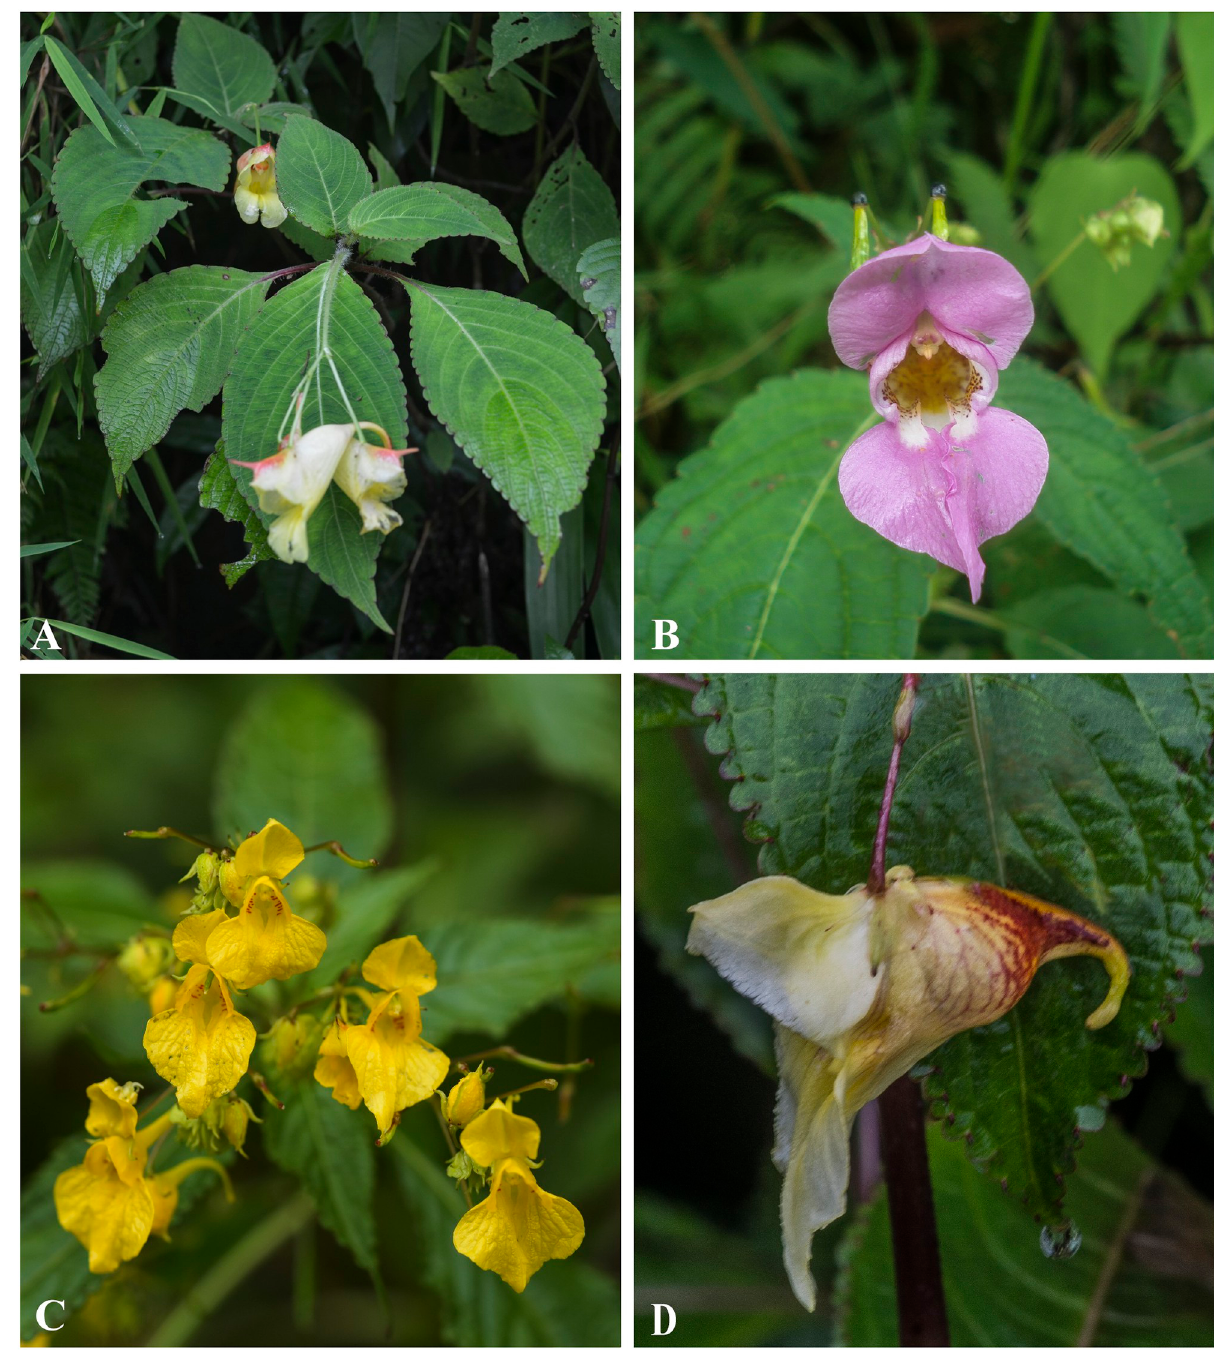
Fig 8. A. Impatiens jurpia ; B. Impatiens chungtienenis ; C. Impatiens desmantha ; D. Impatiens hobsonii . Photographs by Bhakta Bahadur